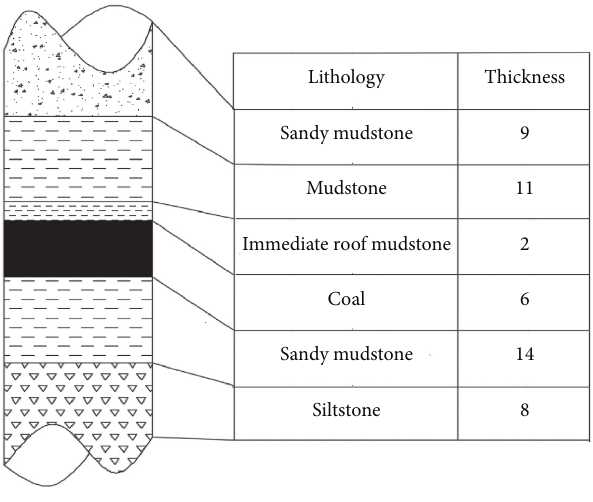
Figure 2: Typical geological column.